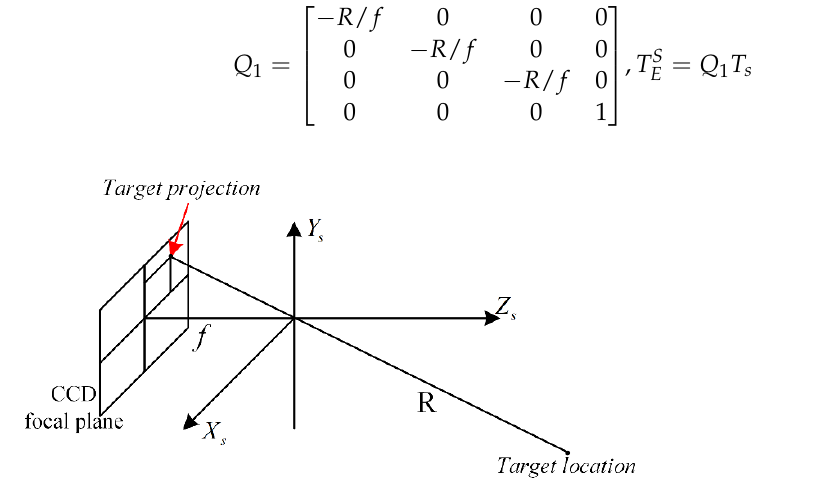
Figure 9. Schematic of positional relationship for target and target projection point in the camera coordinate frame.